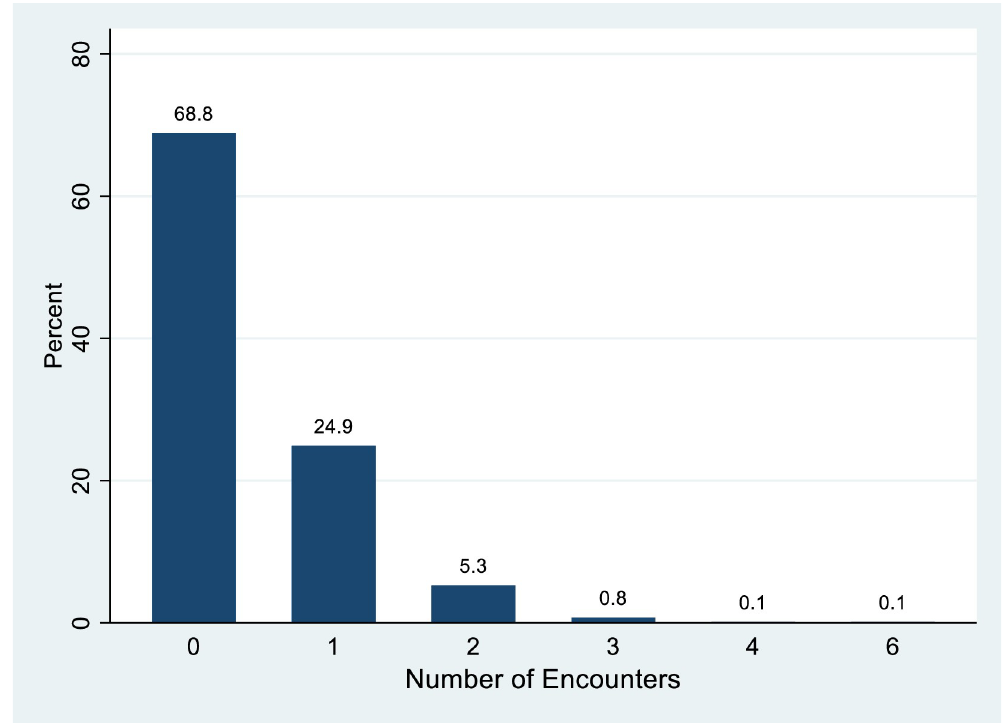
Fig 4. Percent distribution of number of